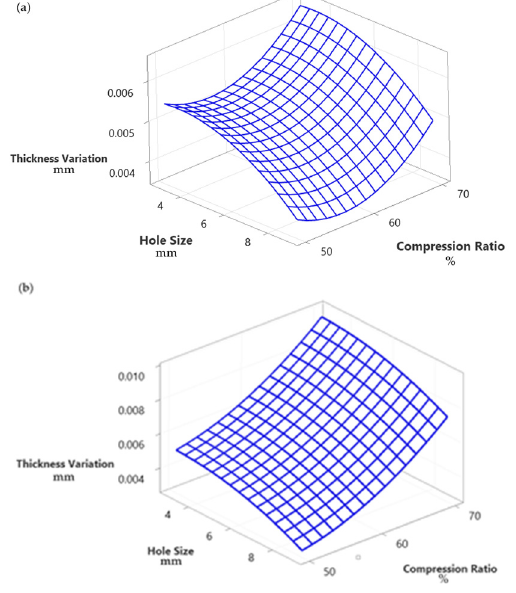
Figure 6. Effects of hole size (mm) and the compression ratio (%) on the thickness variation (mm), ( a ) circular holes, ( b ) rectangular holes.